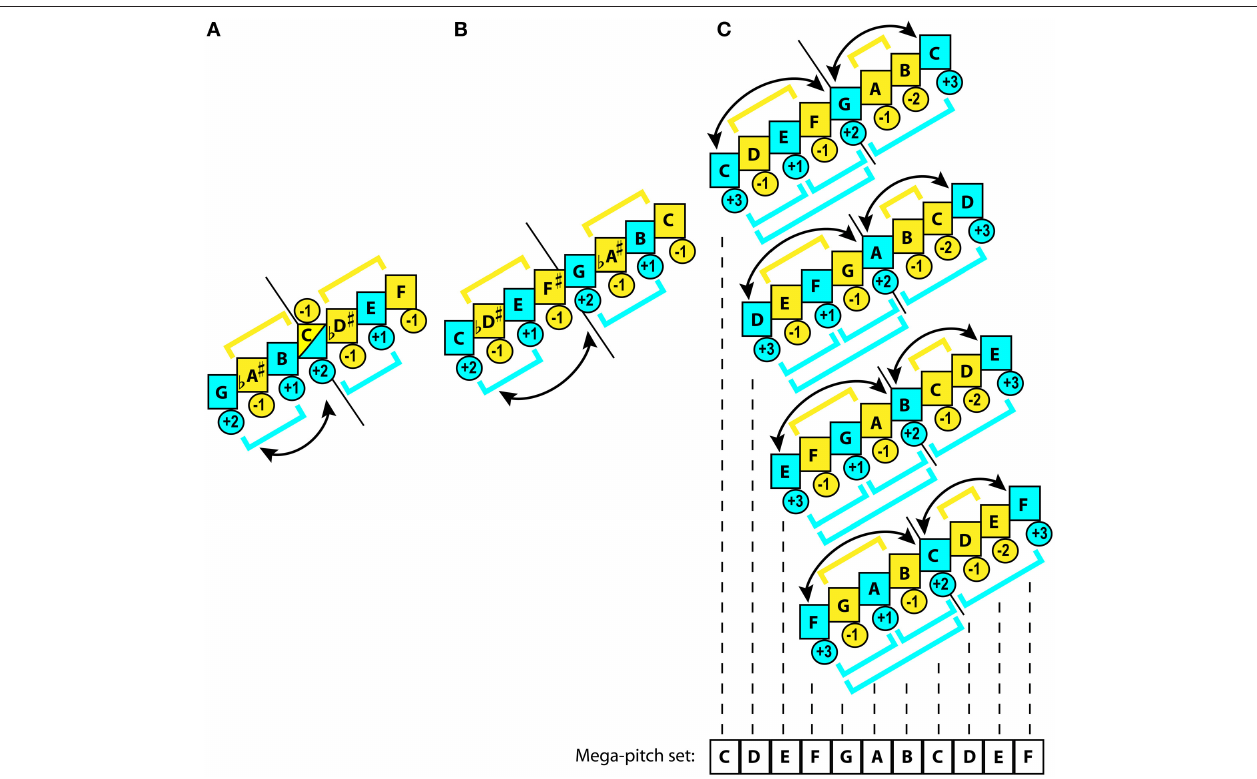
Figure 2 | Genesis of Mixolydian polymodal family. Blue color marks stability, while yellow—instability. Brackets illustrate hierarchic grouping of degrees. Arrows indicate the tendency of tones to alternate as gravitational centers. Figures in circles rate relative gravitational values within the subset: negative indicate instability ( − 2 more unstable than − 1), while positive—stability ( + 3 more stable than + 1). Short black straight line shows the central axis for a mode formed by modal subsets within a mode. Curved arrowed lines indicate the shifts of gravity between the mutable anchors. Placement of this line between two tones indicates a disjunct connection. Placement under the middle of a tone indicates a conjunct connection between the subsets. The dashed black lines display the mega-set membership of the pitches. (A) Mixolydian conjunct heptatonic non-octave mode. The mode has 2 equivalent subsets with gravitational ambiguity in the center. The IV degree alternates from stable to unstable state, depending on the tetrachord in which it is melodically engaged. The hierarchy is limited to the binary distinction between stable degrees, where the lowest tone of the tetrachord receives greater weight. Modal mutability occurs between I and IV degrees. (B) Rotated Mixolydian disjunct heptatonic non-octave mode. This mode has two equivalent subsets with unambiguous gravitational map, where the lowest tone in the tetrachord remains the anchor. Although, its hierarchy is as elementary as in (A) , this mode is closer to the uni-tonicity. Modal mutability here occurs between I and V degrees in the manner of “tonic”-“dominant.” Also equivalence of 4th produces nearly perfect match in tuning between I and VIII degrees. (C) Ionian octave equivalent diatonic mode and its three most common modal transpositions: Dorian (D), Phrygian (E), and Lydian (F). This mode features two inequivalent subsets with contrasting placement of unstable degrees. In the lower pentachord they alternate with stable degrees, whereas in the upper tetrachord they are entangled between the stable margins. Both subsets are conjunct through the V degree, which thereby receives greater modal prominence than the III degree. Also, the upper tetrachord is harmonically understood as the “inversion” of the basic pentachord in reference to the stable degrees. The mode is fully octave equivalent. The very same modal scheme is reproduced in every transposition (C, D, E, F). “Sameness” of the pitch values (i.e., D = D) across the sister-modes despite their difference in functionality for each of the sister-modes generates the